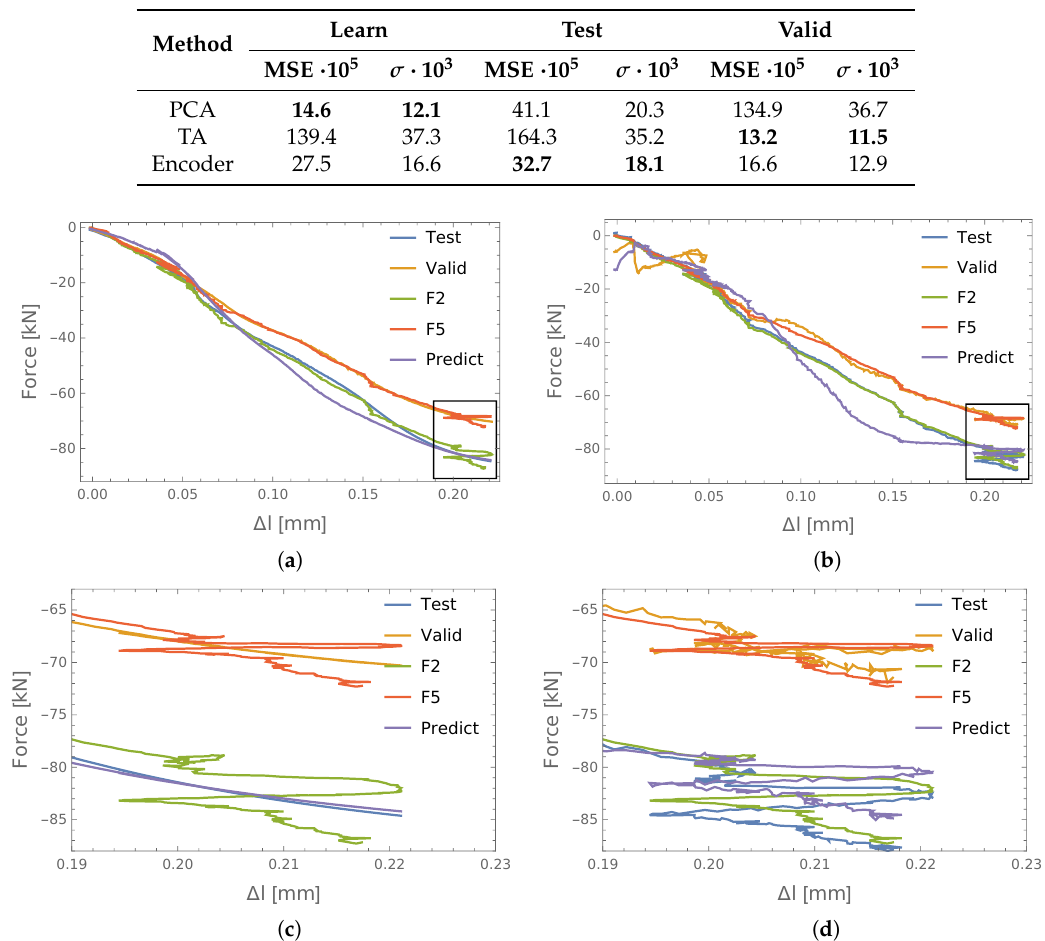
Table 2. Comparison of the learning, testing, and validation errors: P1.